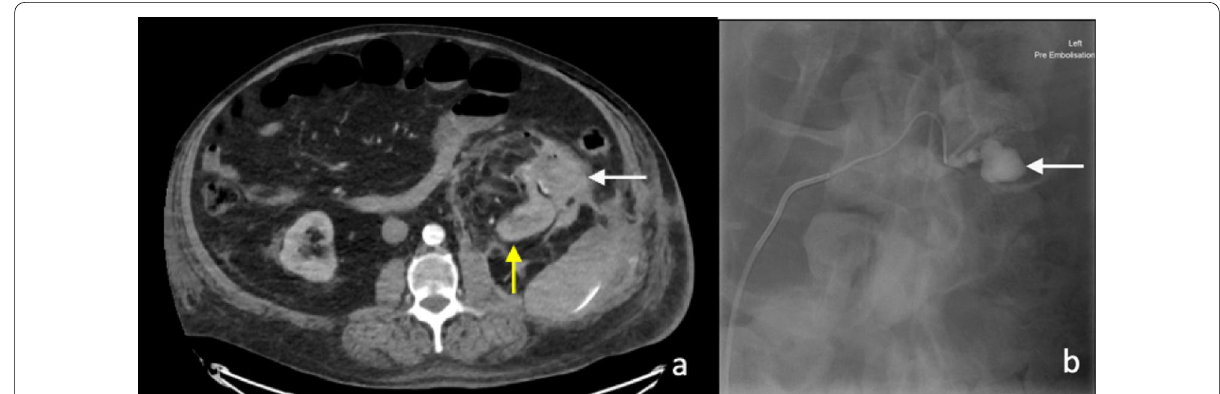
Fig. 2 a Arterial phase CT image of perinephric haematoma (white arrow) at the site of partial nephrectomy. The residual left kidney is indicated by the yellow arrow. b Active extravasation of contrast (white arrow) was confirmed on DSA